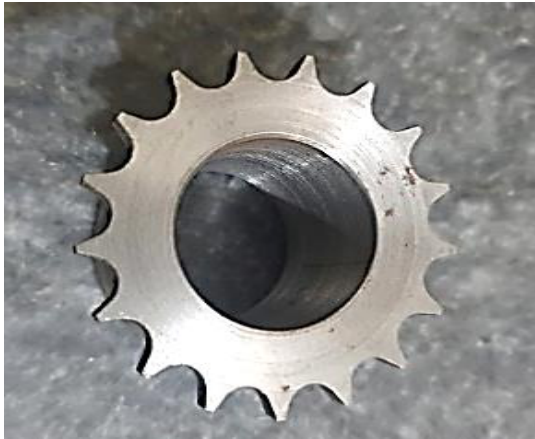
Figure 6. Final part design of timing chain sprocket. Table 9. MRR for AISI 1045 medium carbon